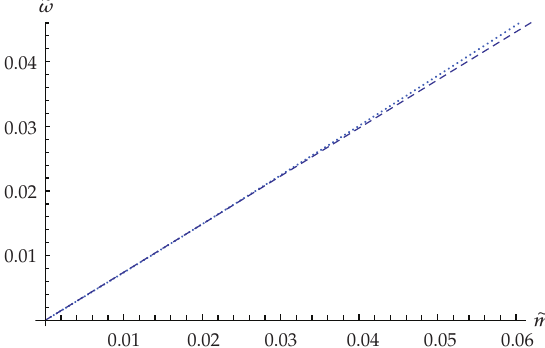
Figure 10: Plot of the spectrum of the ground state from Figure 9 for small bare masses. The dashed line corresponds to the linear behavior from (cid:3) 4.125 (cid:4)